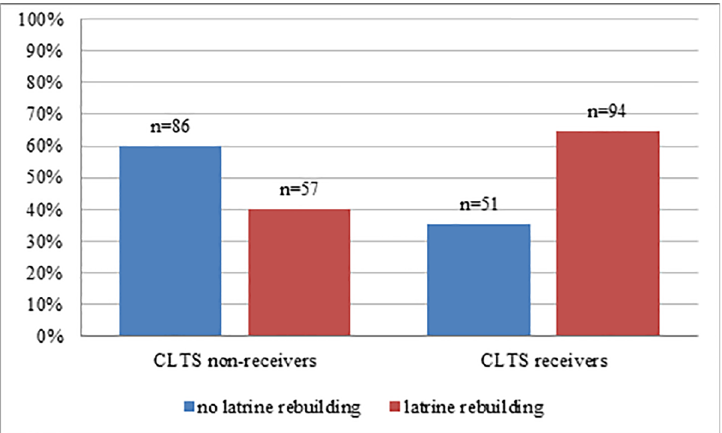
Fig 1. Effect of CLTS on rebuilding. Differences in latrine rebuilding between people who received CLTS-related information and people who did not.